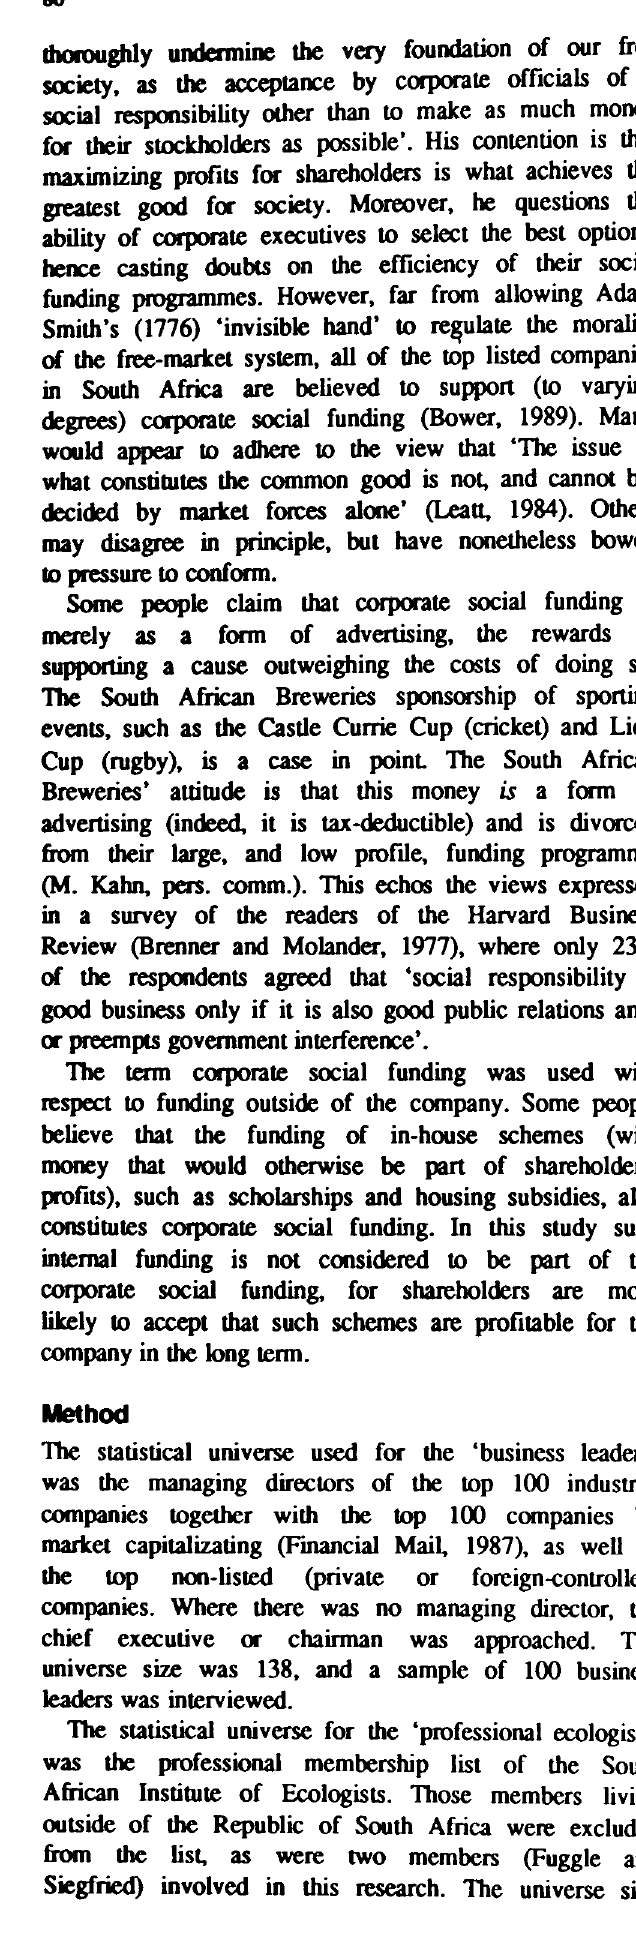
Figure 1 Responses IO the statement, business companies in South Africa should fund programmes to the benefit of society out of money that would otherwise be pan of shareholders' profits. P • .94 (Agree versus